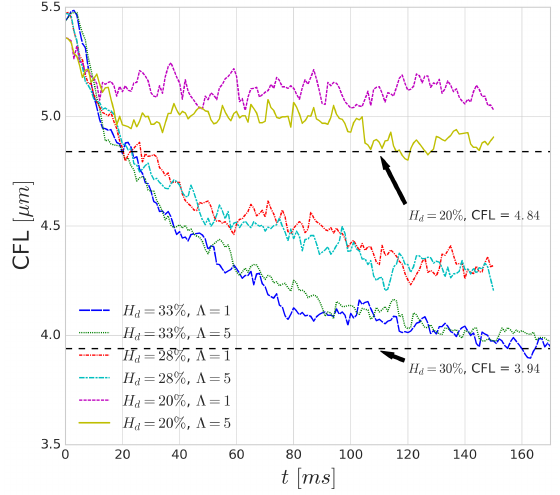
Figure 14. Evolution of the CFL-width over time in the performed pressure driven channel flow simulations with a tube diameter of D = 70 µ m and Re = 1.3 for different haematocrit values. The dashed black lines indicate values for this tube diameter from